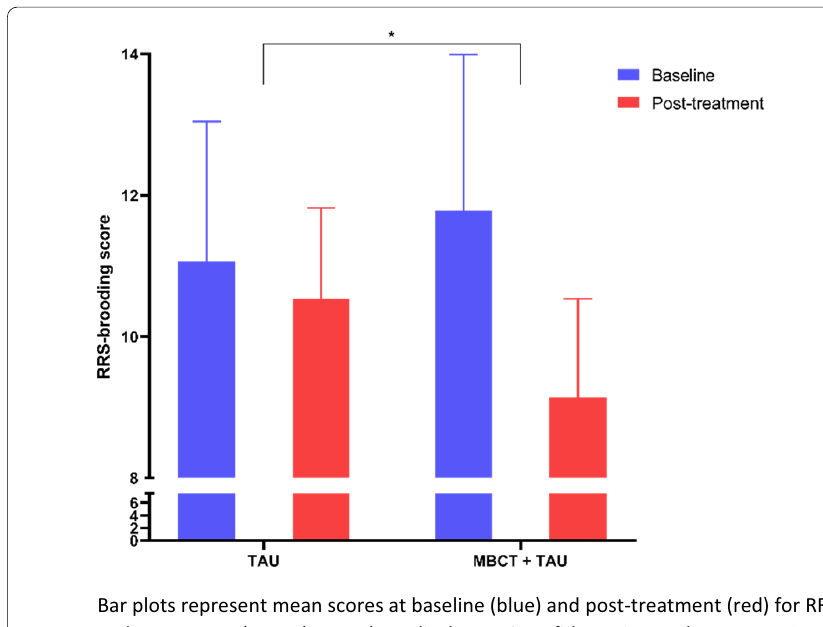
Bar plots represent mean scores at baseline (blue) and post-treatment (red) for RRS_brooding scores for TAU ( n = 15) and MBCT+TAU ( n = 14). Error bars display 95% confidence intervals. RRS : rumina…ve response scale, MBCT = Fig. 1 Effect of mindfulness‑based cognitive therapy on trait depressive rumination over time